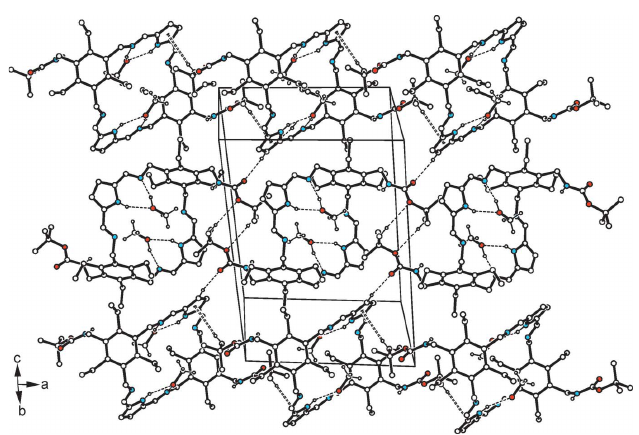
Figure 3 Packing diagram of the 1:2 host–guest complex. Hydrogen bonds and C— H (cid:2)(cid:2)(cid:2) (cid:2) interactions are represented by dashed lines and dashed double lines, respectively. For the sake of clarity, the H atoms of the host molecule not involved in hydrogen-bonding interactions or C—H (cid:2)(cid:2)(cid:2) (cid:2) contacts are